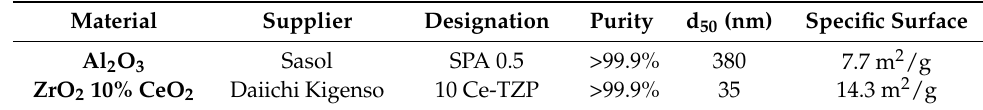
Table 1. Description of starting